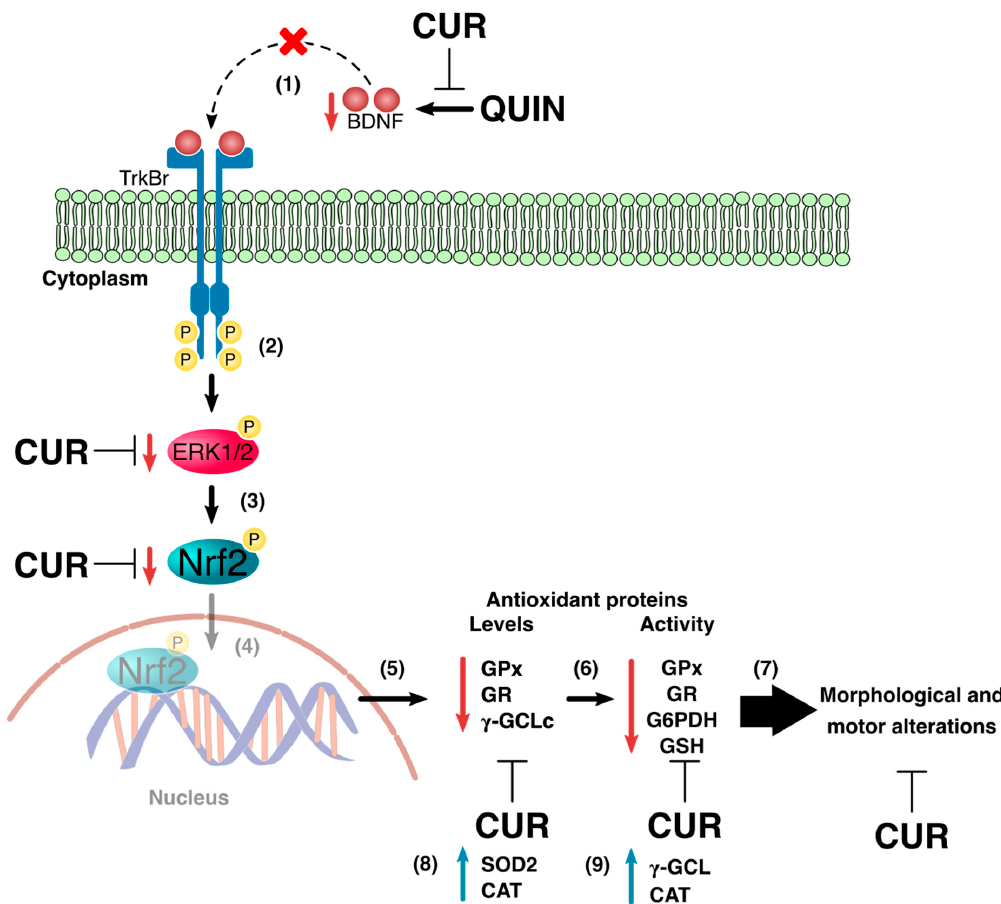
Figure 9. Curcumin (CUR) administration protected brain tissue against the damage induced by quinolinic acid (QUIN). QUIN administration decreased the protein levels of the brain-derived neurotropic factor (BDNF) on day 7, preventing the stimulation of its receptor the tropomyosin receptor kinase-B (TrkBr) ( 1 ). The decrease in TrkBr signaling avoided the protein extracellular signal-regulated kinase-1/2 (ERK1/2) activation ( 2 ) and consequently, the nuclear factor erythroid 2 related factor 2 (Nrf2) accumulated ( 3 ). This allowed for Nrf2 to be translocated into the nucleus (diffuse area) ( 4 ). The decrease in Nrf2 levels diminished the protein levels of glutathione peroxidase (GPx), glutathione reductase (GR) and γ -glutamylcysteine ligase catalytic subunit ( γ -GCLc) ( 5 ), and the enzyme activity of GPx, GR, and glucose-6-phosphate dehydrogenase (G6PDH), as well as glutathione (GSH) levels ( 6 ), inducing cellular damage and motor alterations ( 7 ). Finally, QUIN injection increased superoxide dismutase 2 (SOD2) and CAT levels ( 8 ), and the γ -GCL and CAT activities ( 9 ). On the other hand, CUR treatment 24 h after QUIN injection prevented the decrease in BDNF levels, avoiding the reduction of ERK1/2 activation and Nrf2 stabilization and its nuclear translocation and activation, restoring the levels and the activity of antioxidant enzymes and GSH levels, improving morphological and motor alteration induced by QUIN.